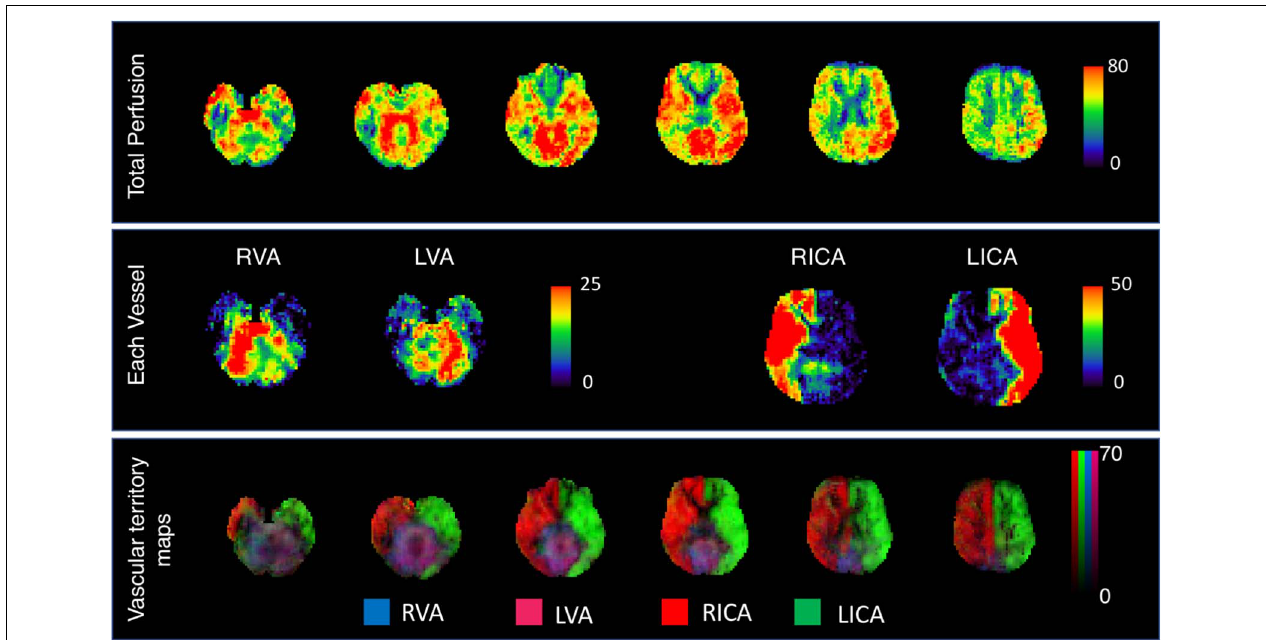
FIGURE 5 | Vessel-encoded pCASL data from a Heart and Brain Study participant. The top panel displays total cerebral perfusion in ml/100 g tissue/min across six horizontal slices in native ASL space. Warmer colours representing regions of higher perfusion. The middle panel displays perfusion from each of the four encoded vessels for a single slice (RVA, LVA: right and left vertebral arteries, RICA, LICA: right and left internal carotid arteries). The bottom panel displays combined vascular territory maps where signals from each of the four feeding arteries are summed (green: LICA, red: RICA, blue: RVA, and magenta: